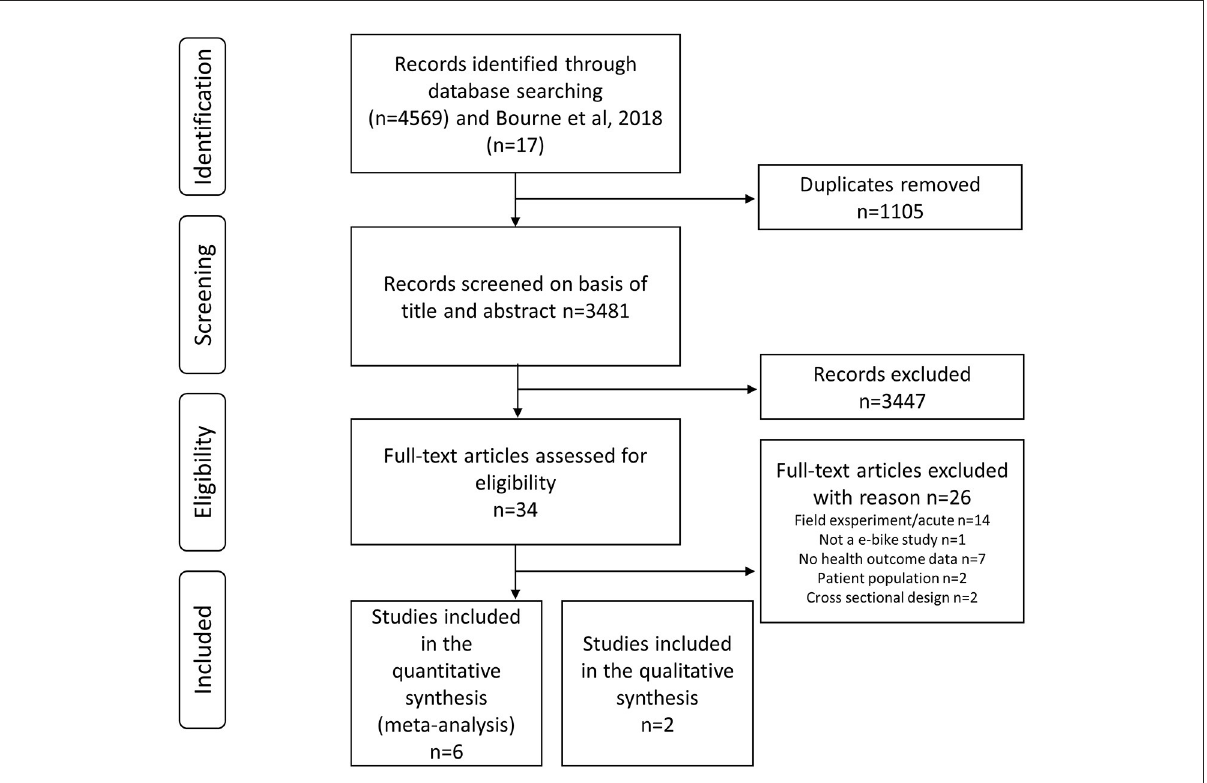
FIGURE1 Flow chart of included studies as proposed by Preferred Reporting Items for Systematic Reviews and Meta-Analyses statement